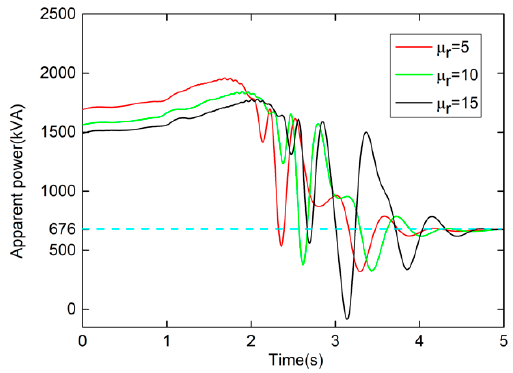
Figure 27. Apparent power with MSW. Table 6. Motor performance at rated operation.